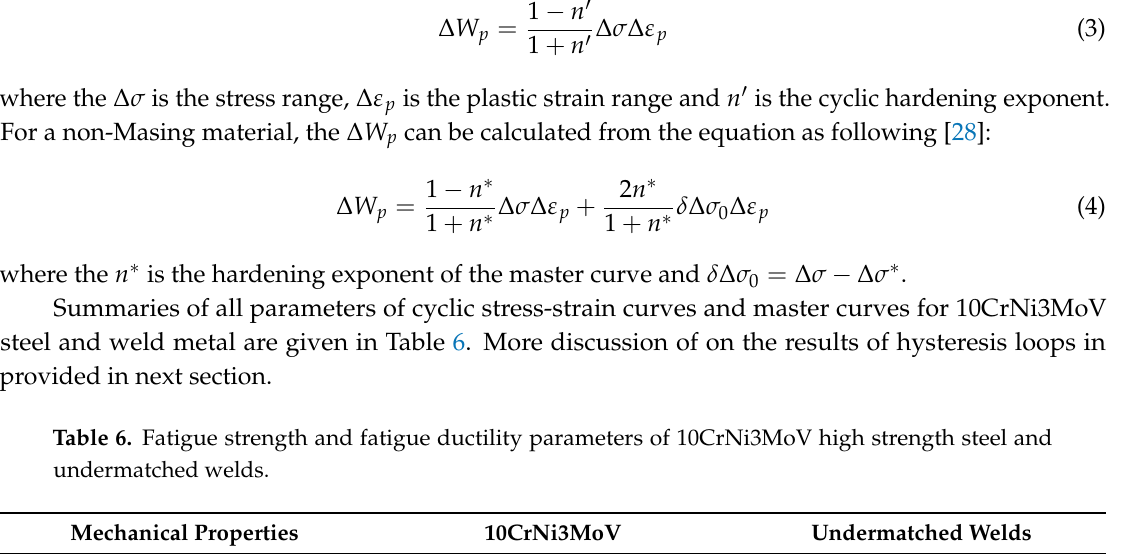
undermatched welds.